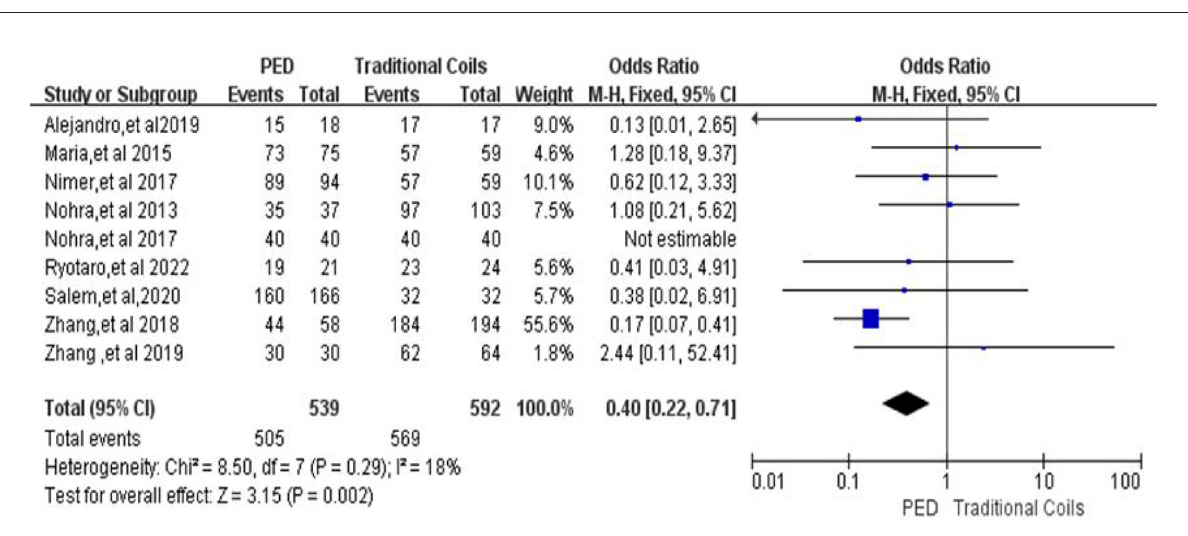
FIGURE6 Forest plot and meta-analysis of favorable functional outcome of patients at last